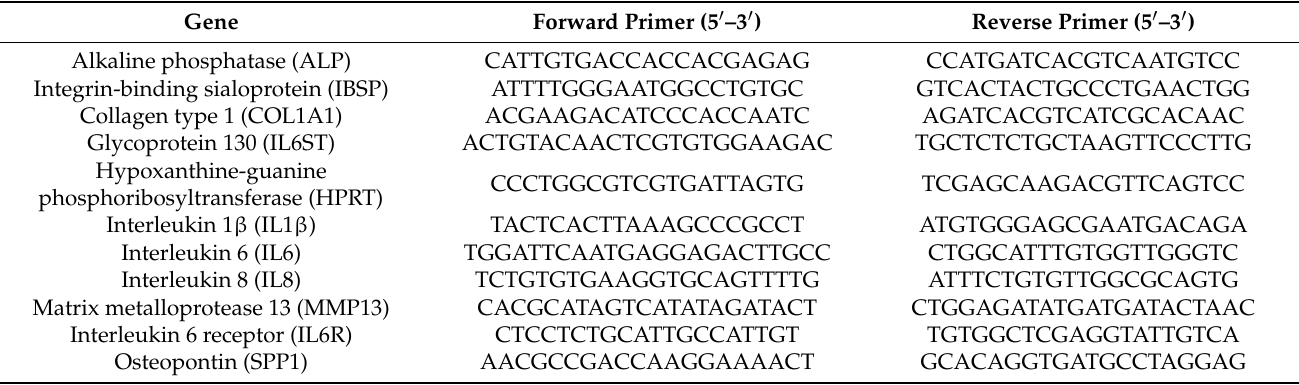
Table 1. cDNA target sequences for semiquantitative real-time PCR. Primer pairs were purchased from Merck KGaA (Darmstadt, Germany).